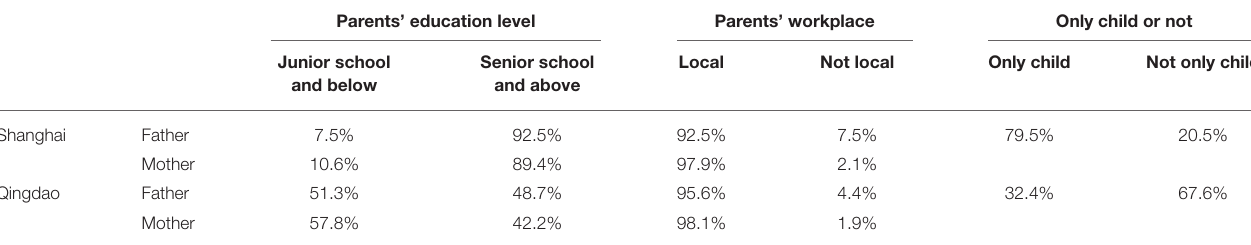
TABLE 1 | Family background